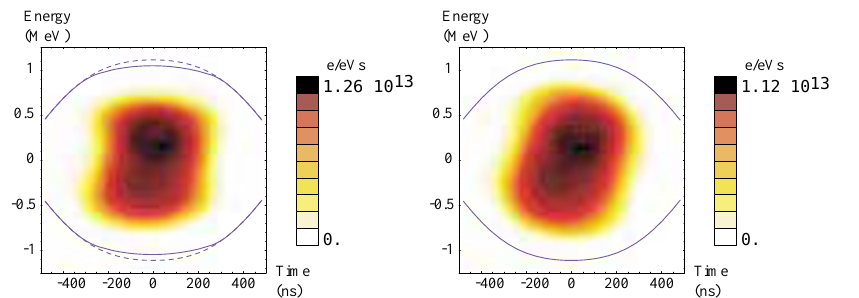
FIG. 2. (Color) Phase space reconstructions, with (left) and without (right) space charge. Note the different density scales.